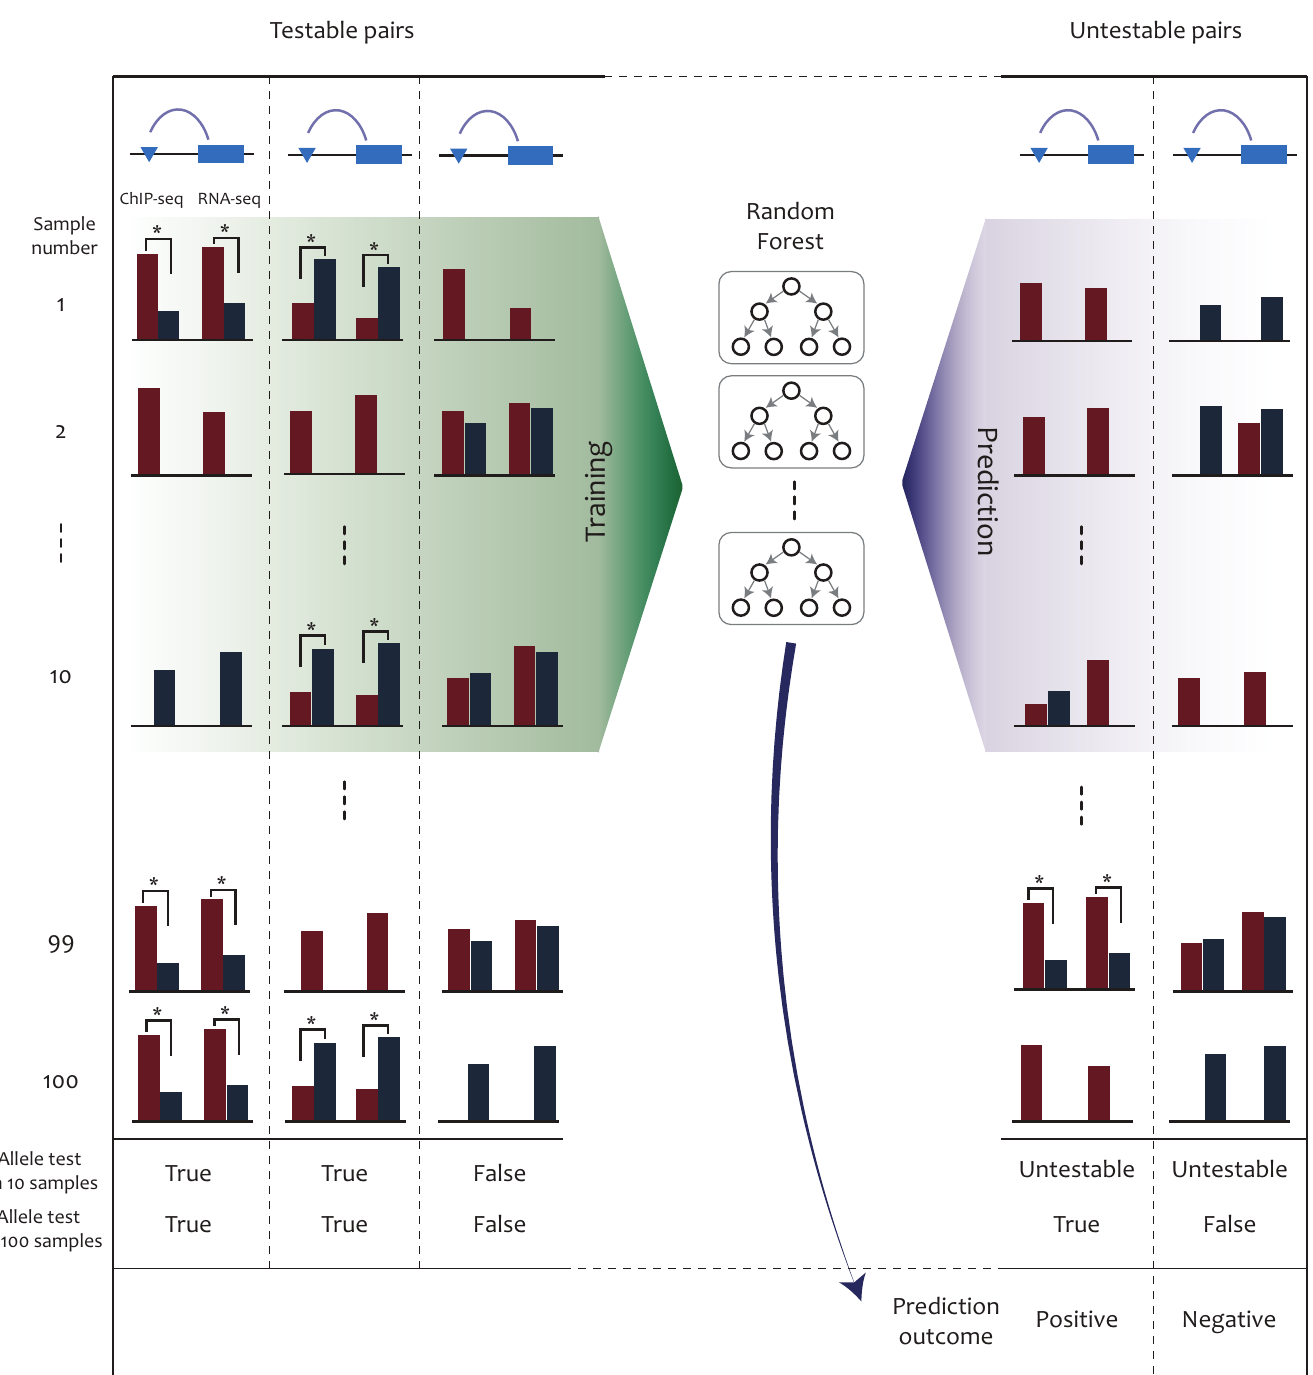
Fig 4. Schematic of predictive allelic mapping using a small number of samples. In this illustration,the 10 samples in the first 10 rows are used for trainingand prediction. Over the whole-genome, testable and untestablepairs of regulatoryregionsand transcripts are collected.The red and blue bars represent the number of allele-specific ChIP-seq or RNA-seq reads. Heterozygotesshould have the two bars simultaneously whereas homozygotes should have only one. The prediction outcome is validatedby performing allelictests using additionalsamples. In this illustration, the remaining90 sampleswere used for this purpose. For example,one of the untestablepairs is calledpositive by RandomForest, and indeedshows alleleimbalance in one sample heterozygous for the regulatoryregionand transcript.